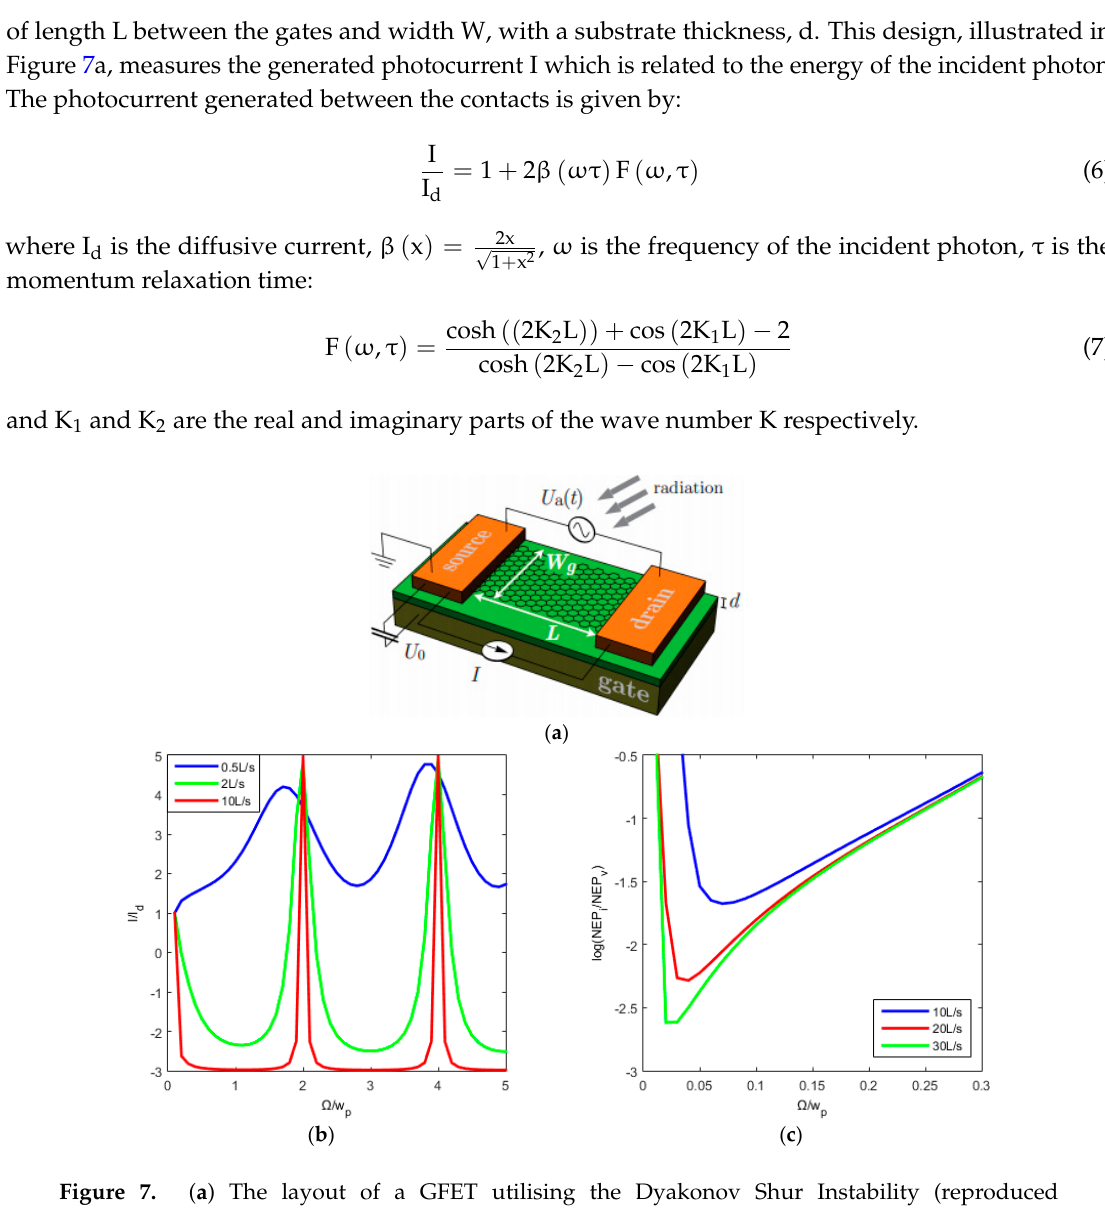
(cid:17) (cid:16) NEP I against photon frequency with lower noise at higher momentum relaxation ( c ) log NEP V